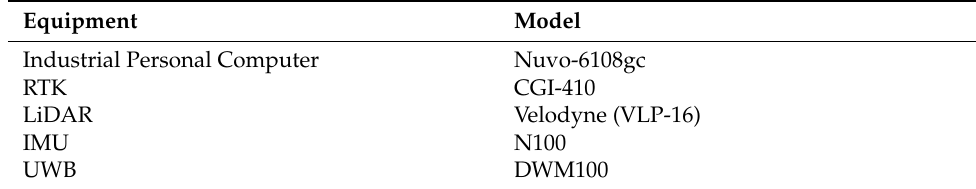
Table 2. Information about experimental